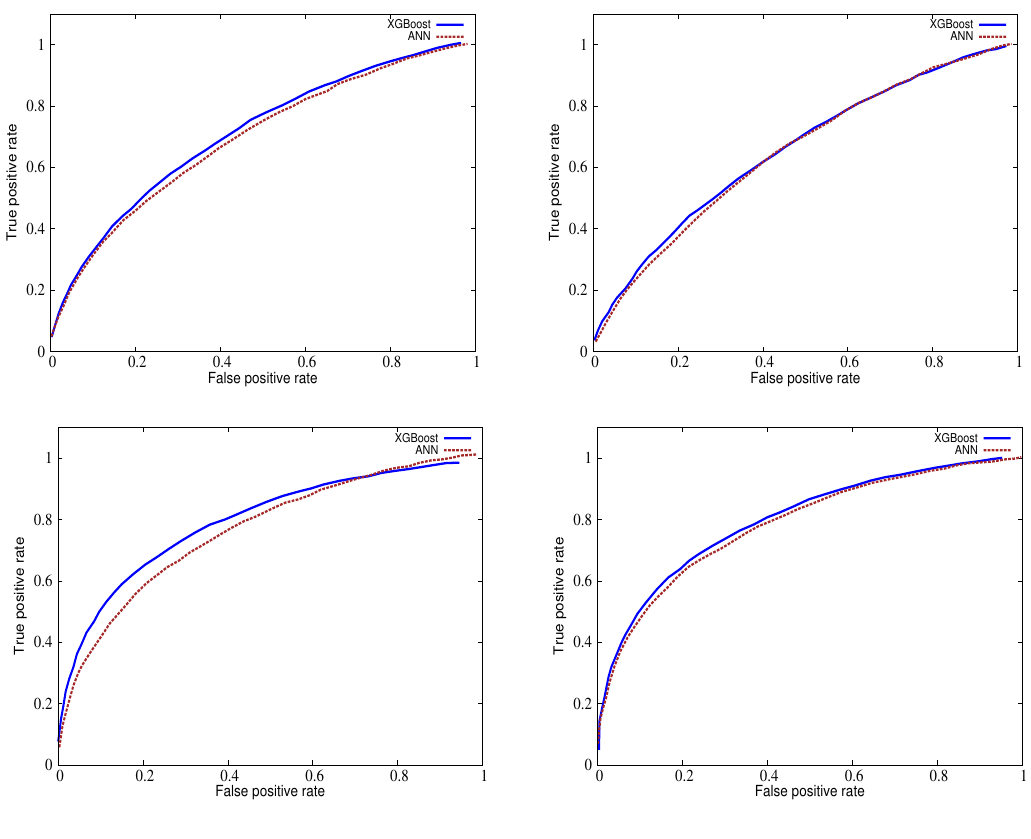
Figure 17 . ROC curves of gluon fusion for Type I BP I (top left), Type I BP II (top right), Type II BP I (bottom left) and Type II BP II (bottom